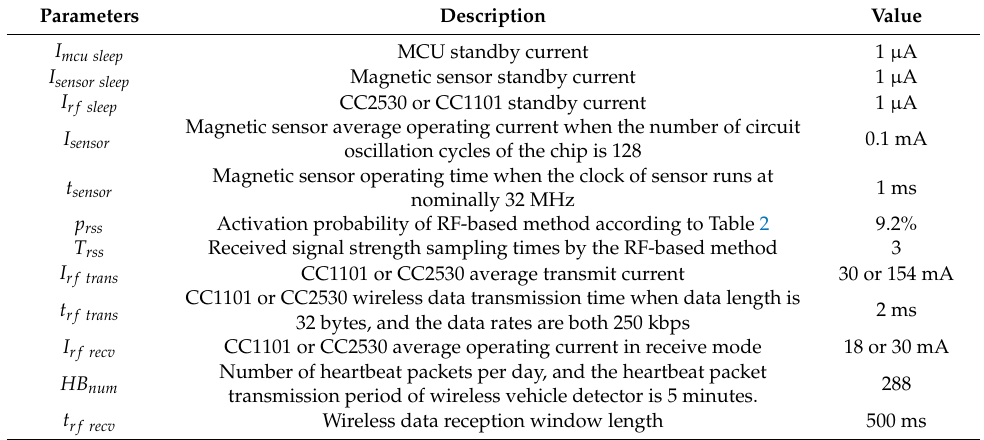
Table 3. Time duration and current consumption for each activity of the proposed method.